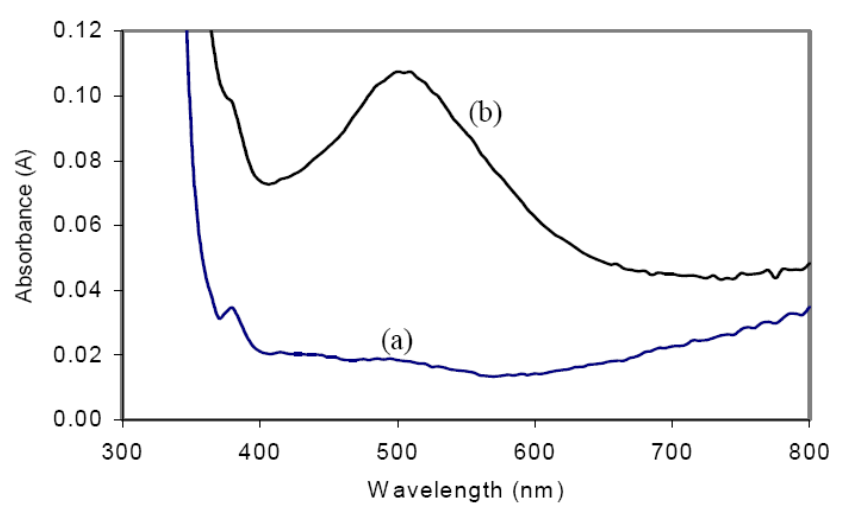
Figure 2 . Absorbance spectra of the optical biosensor in the absence (a) and presence (b) of catechol (6.5 mM).